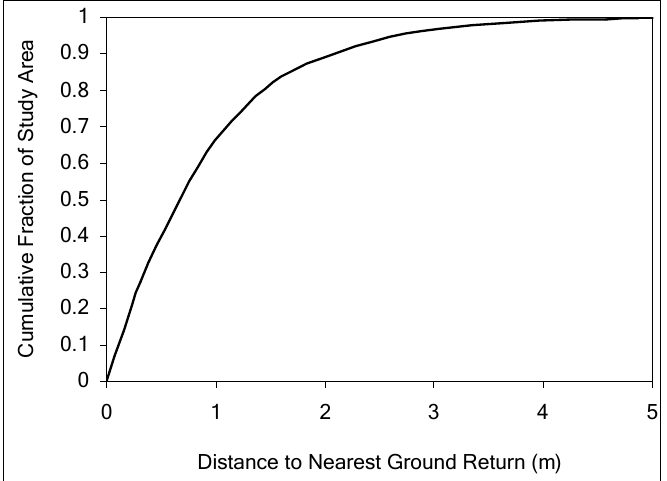
Figure 4. Cumulative frequency distribution for the distance to the nearest ground